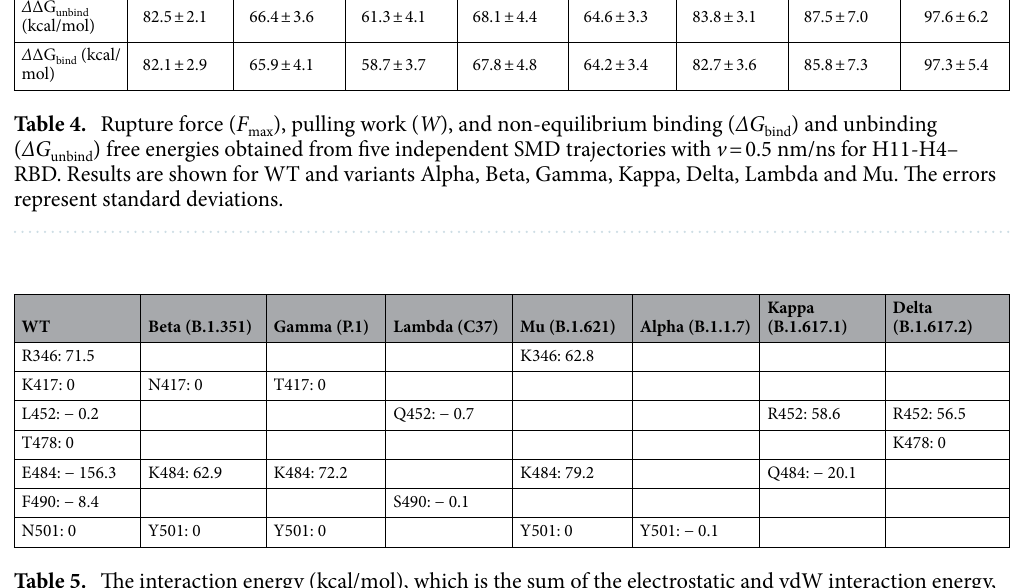
Table 5. The interaction energy (kcal/mol), which is the sum of the electrostatic and vdW interaction energy, between the important residues of RBD and H11-H4 in WT and different variants. The results were obtained in a [0, t max ] time window and averaged from five SMD trajectories performed at a pulling speed of v = 0.5 nm/ ns. Black and red refer to WT and mutations, respectively.